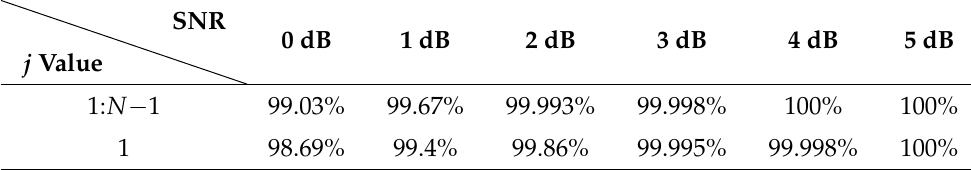
Table 6. Comparison of the detection rate between L 2 ( µ ) and L 3 ( µ )